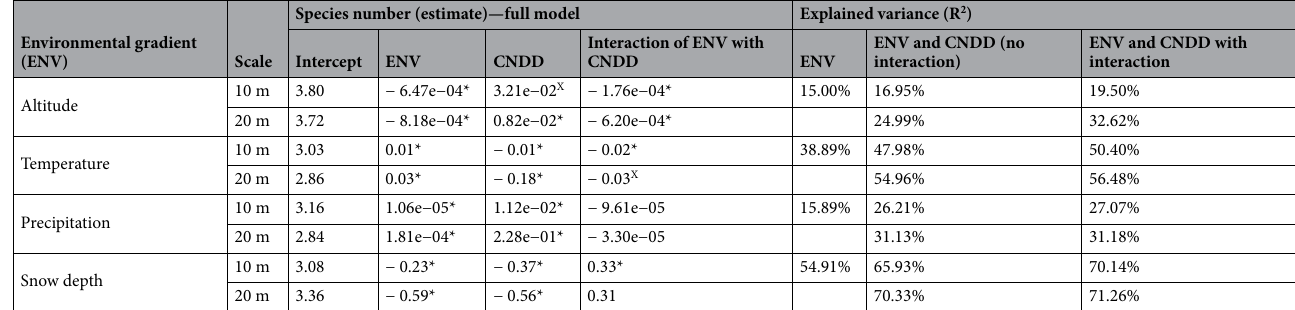
Table 2. Number of species explained by generalized linear models across environmental gradients (altitude, temperature, precipitation and snow depth referred in models as ENV) and CNDD in 10 m and 20 m scale. Estimated coefficients are shown with significance (* for P ≤ 0.05, x for P ≤ 0.1) and explained variance is in %, both for 10 m and 20 m quadrats. The coefficient of determination (R 2 ) in generalized linear models was computed gradually (only ENV, ENV and CNDD, ENV * CNDD) as 1-residual deviance over null